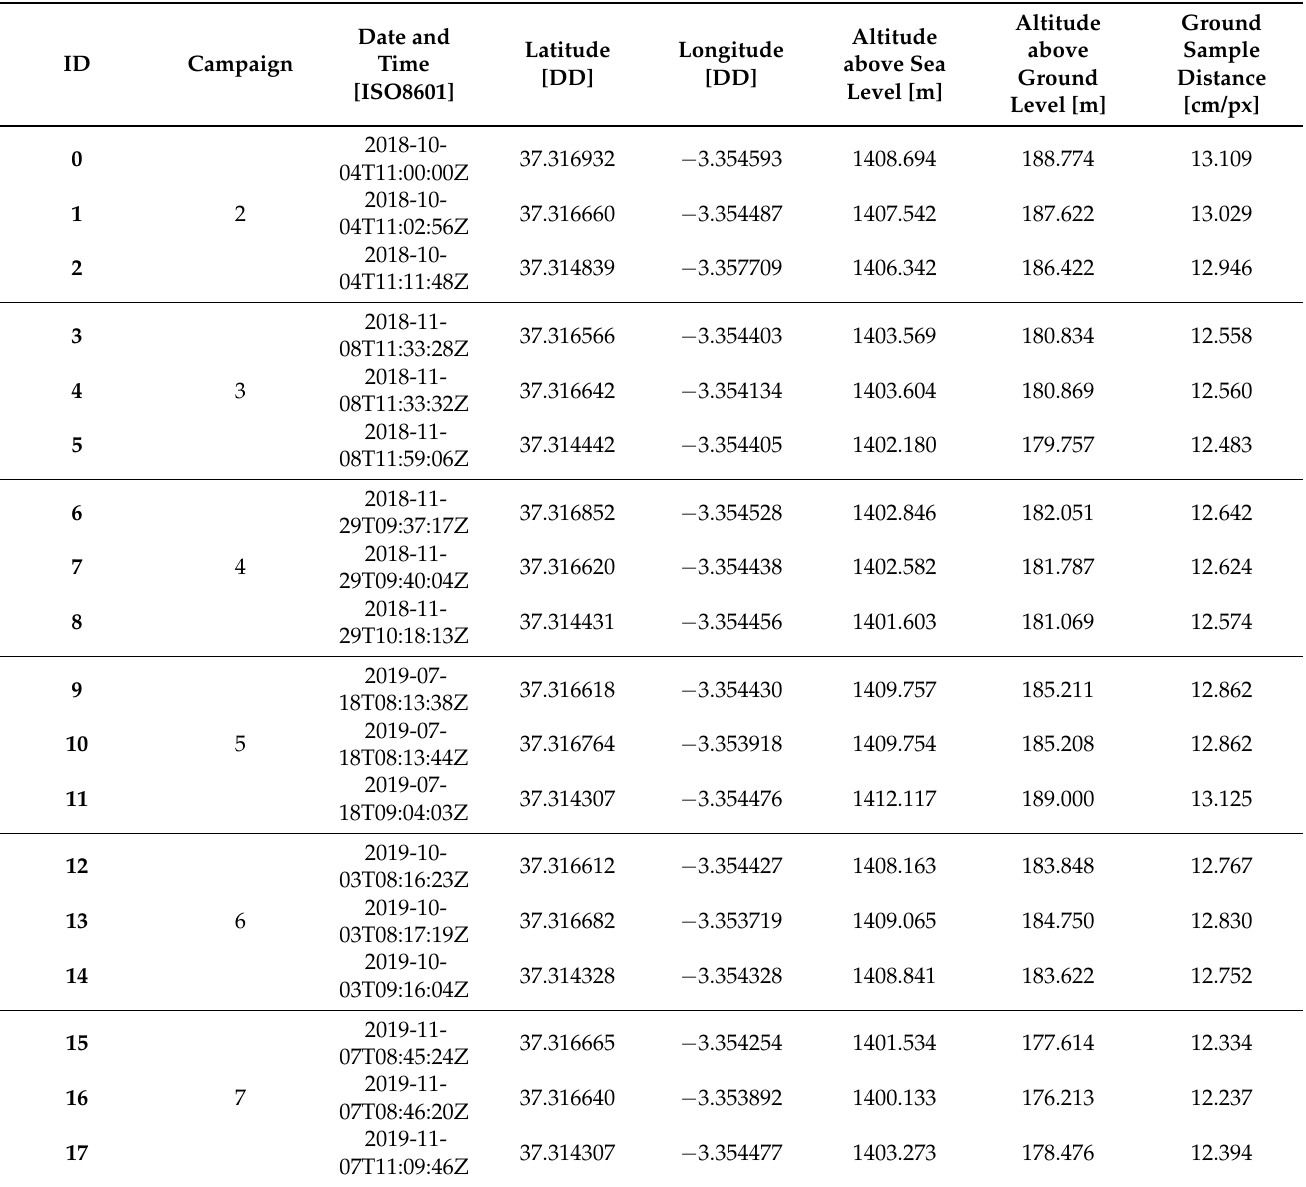
Table 1. Detailed characteristics of the 18 captures used to train and test the proposed model. Campaign is an identifier of the flight number. For each flight made in different months, 3 captures are